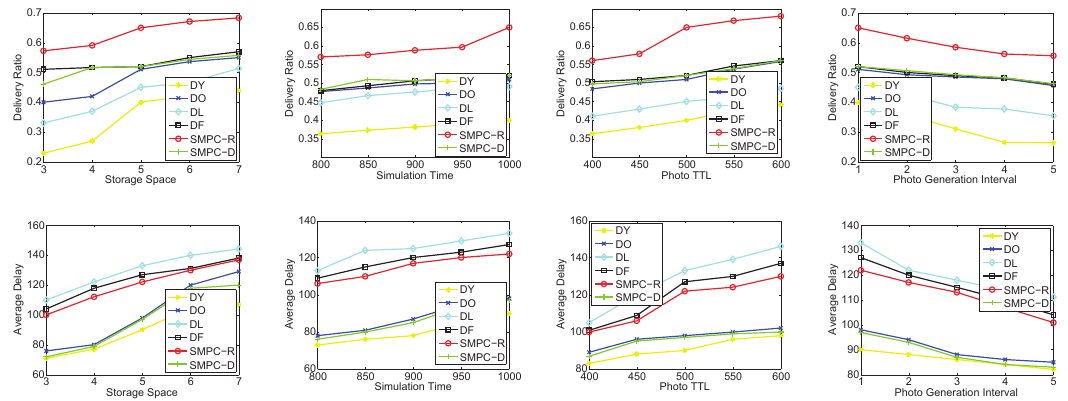
Figure 15. Performance comparisons on the geolife trace set : delivery ratio and average